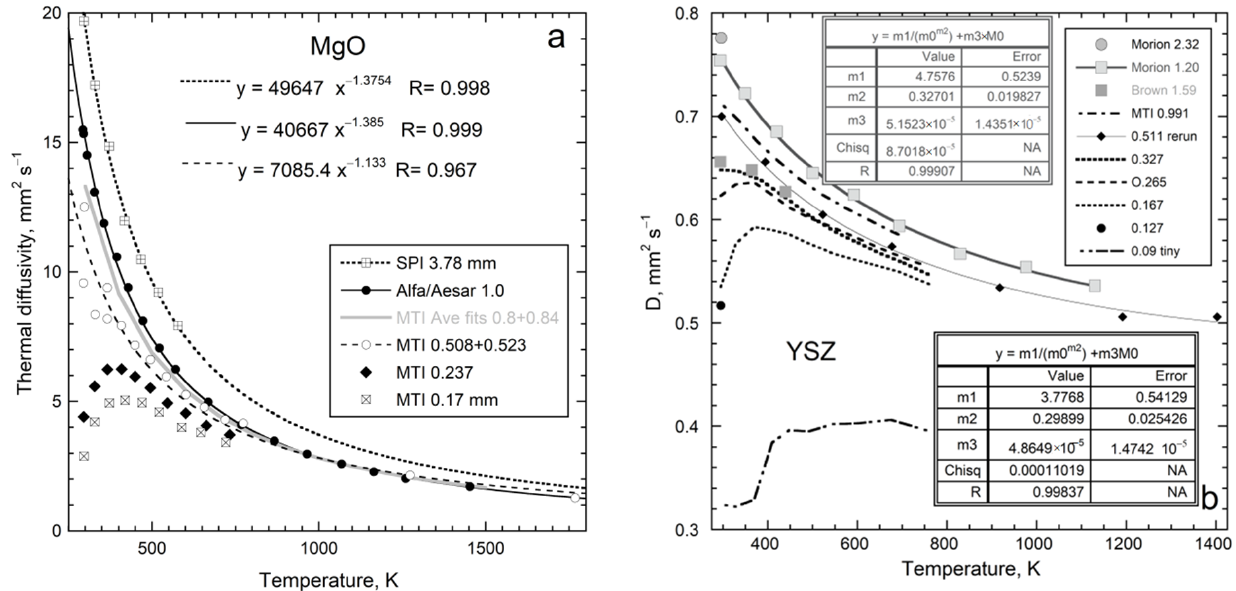
Figure 10. Thermal diffusivity of cubic insulators vs. temperature for various thicknesses. Insets list samples from different sources and their thicknesses, plus fits: ( a ) MgO, where surface hydration is possible. Some datasets with similar thickness were merged, as indicated in the inset. The ~0.5 mm samples diverge from the power law but are still reasonably fit. ( b ) Yt-stabilized cubic zirconia. Colorless samples with L < 1 mm are from MTI Corp., whereas thick samples are from Morion Company. Lower D for brown colored YSZ from Pretty Rock Inc. is attributed to additional impurities. Solid lines are least squares fits to the high- T datasets using Equation (21). Data on the thinnest section is more uncertain, due to lateral size. However, even with an uncertainty of 20%, these D -values remain below trends for larger